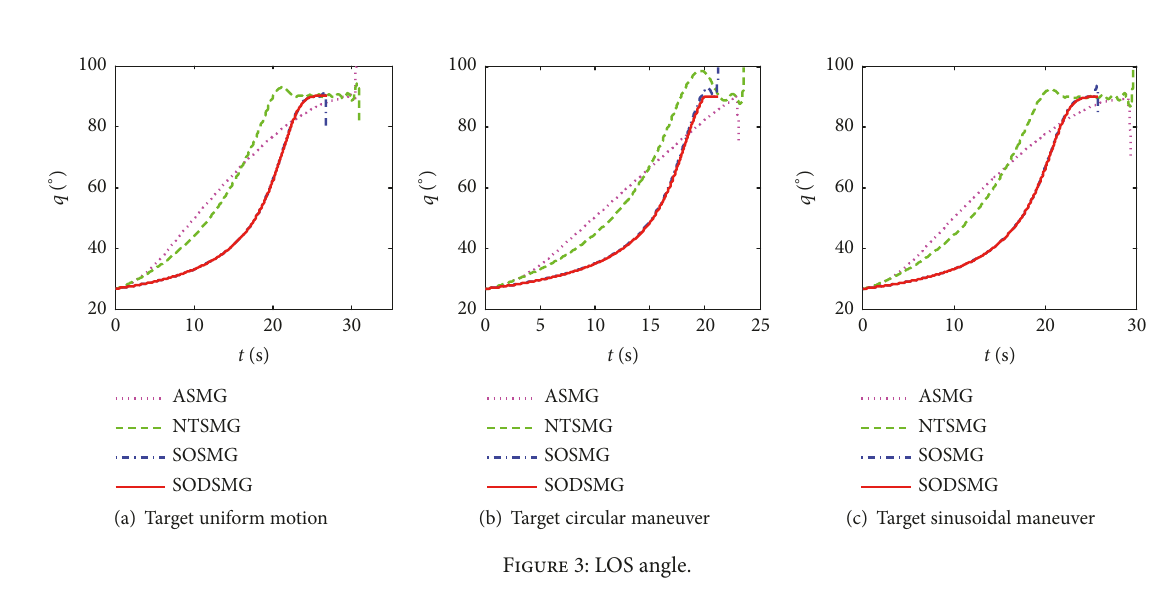
Figure 2: The trajectories of missile and target.